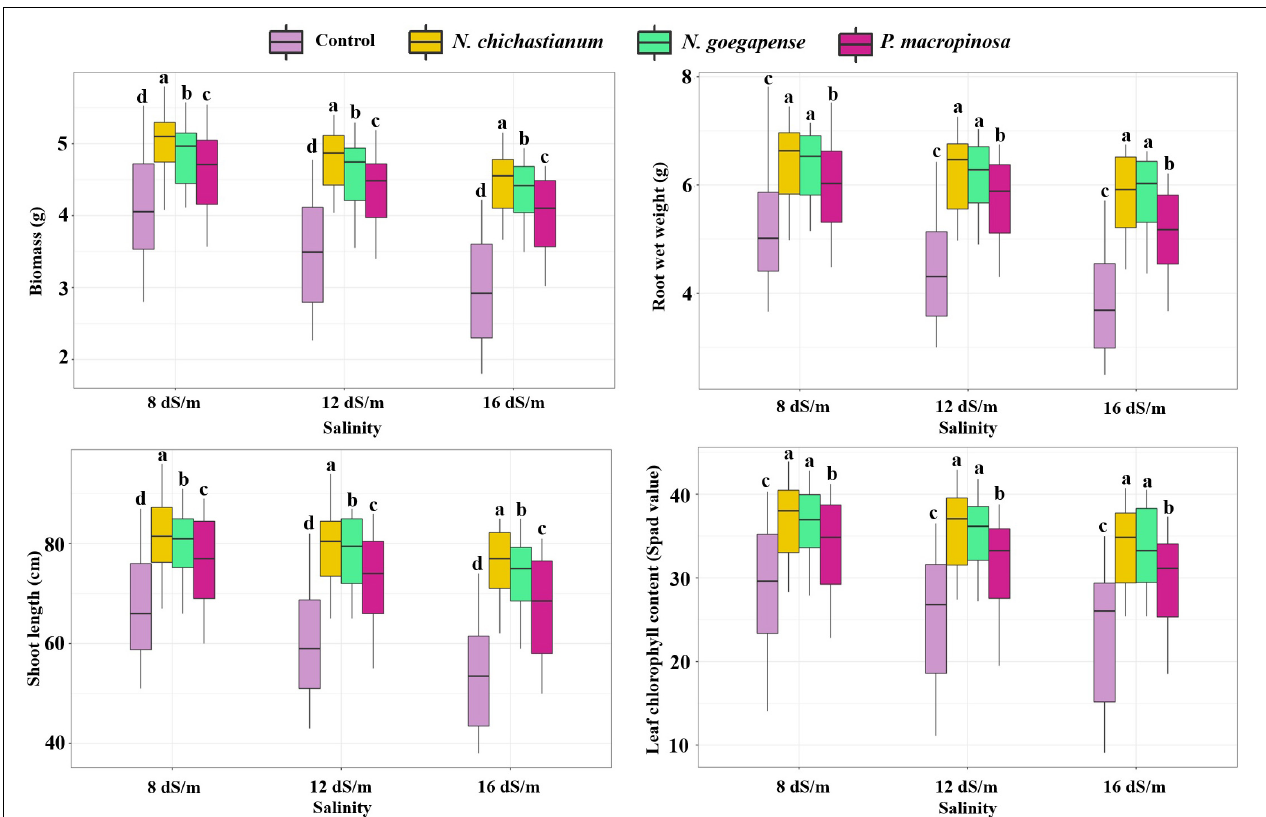
FIGURE 2 | The positive effects of halotolerant endophytic fungi species on salinity stress resistance abilities of barley plants. Different levels of drought stress and different fungal treatment are shown on the horizontal axis and colorful boxes, respectively. Various letters on the top of bars display significant differences between mean values of different fungal treatments under the different levels of salinity stress at p ≤